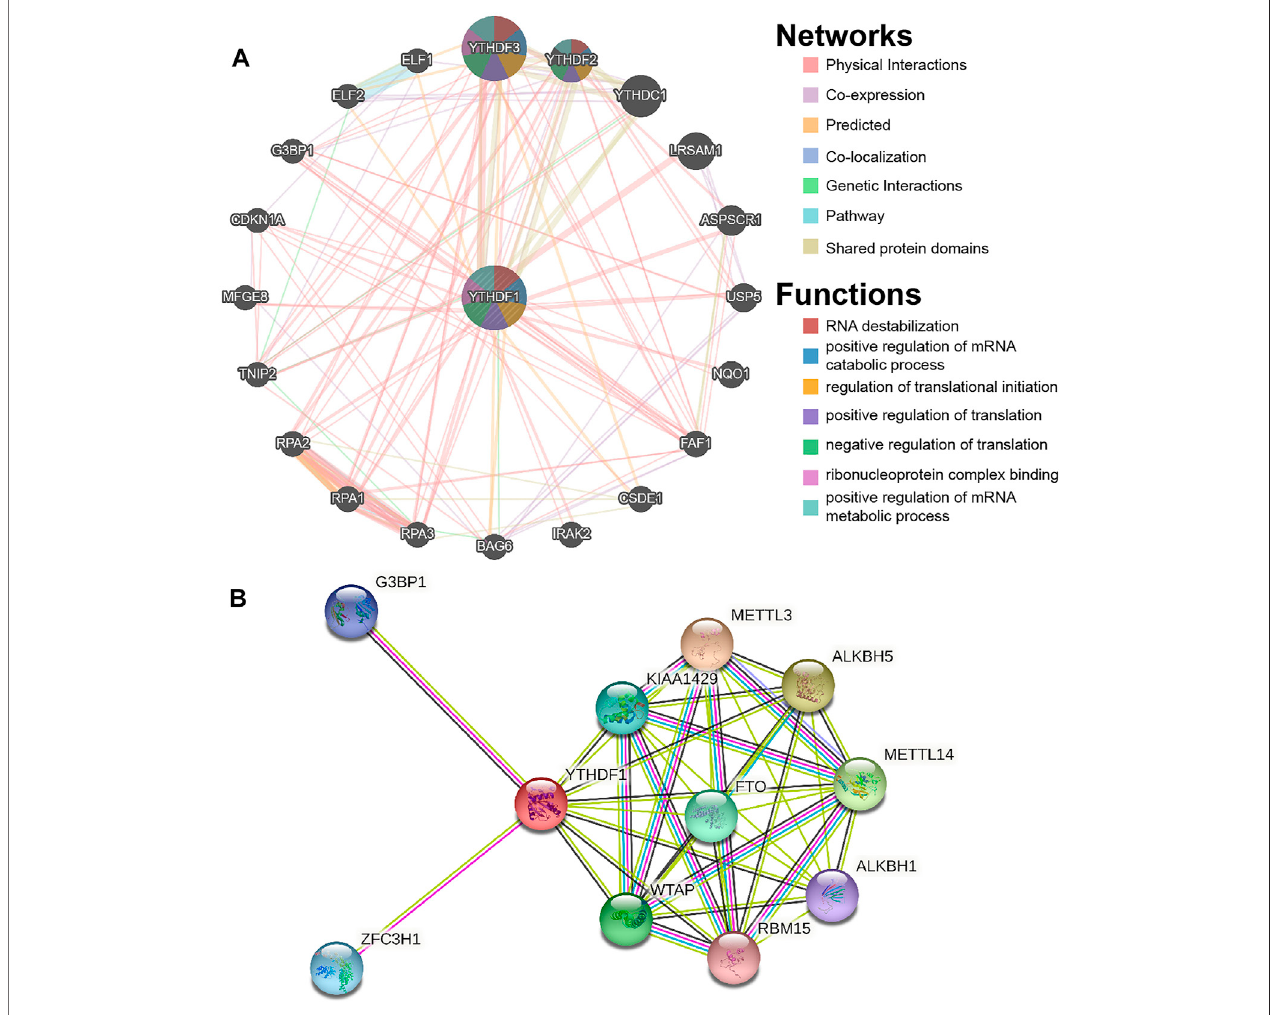
FIGURE 5 | Gene – gene interaction (GGI) and protein – protein interaction (PPI) analysis of the YTHDF1. (A) YTHDF1 ’ s GGI network. (B) YTHDF1 ’ s PPI network.